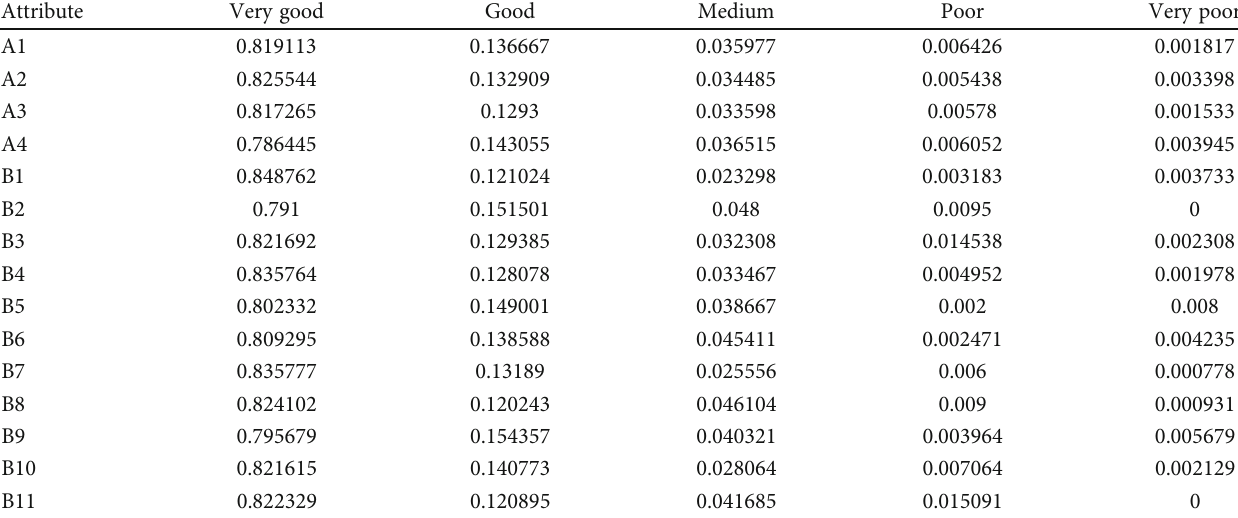
Table 10: Attribute membership for second and fi rst